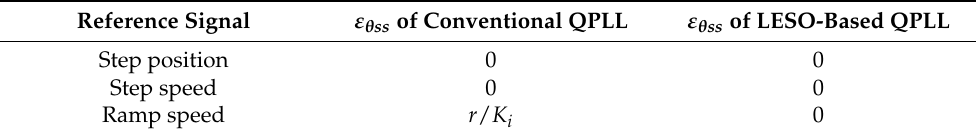
Table 1. Steady-state position tracking error of the two QPLLs under different reference signals. Reference Signal